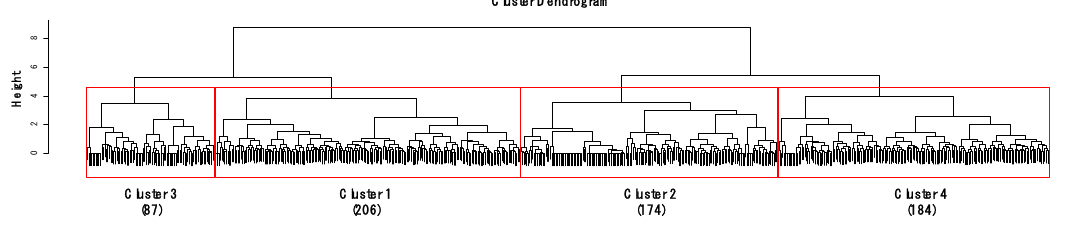
Figure 2. Dendrogram of cluster analysis based on gastropod assemblages using Ward’s linkage method with the Bray–Curtis dissimilarity. Height on the y-axis indicates distances of merging clusters, reflecting the distance between the samples. Numbers in parenthesis represent the number of sampling sites in each cluster.